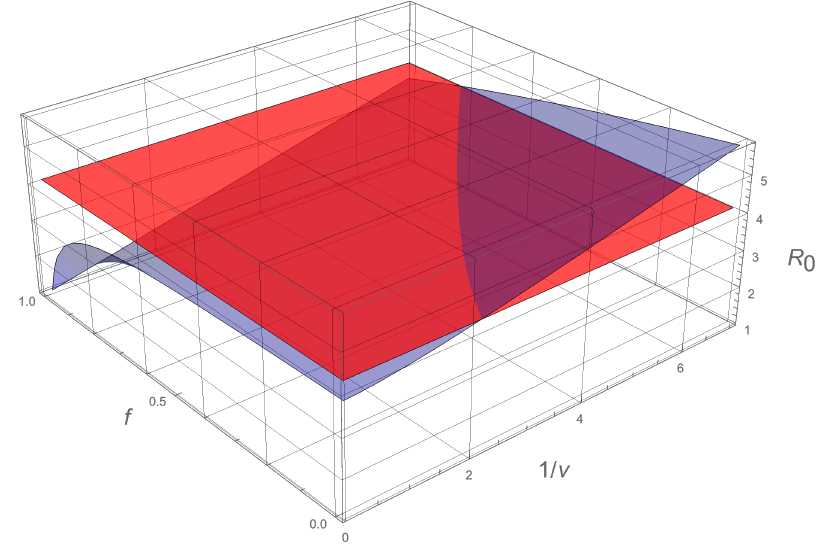
Figure 6. In this figure, we use 1/ η = 7 days, and we plot the basic reproductive number R 0 as a function of f and 1/ ν using (9) with χ 2 = 0.38, which corresponds to the data for China in Table 2. If both f and 1/ ν are sufficiently small, R 0 < 1. The red plane is the value of R 0 =